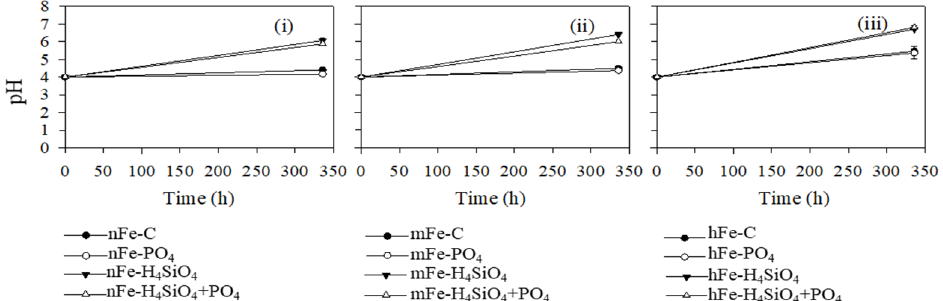
Figure 4. The initial pH changes with treatments ( i - iii ) versus time during anoxic conditions. Data represent the mean; whiskers represent the standard deviation ( n = 3). Goethite: Fe; no Fe: nFe; medium Fe: mFe; high Fe: hFe; phosphate: PO 4 ; silicic acid: H 4 SiO 4 ; and control: C.